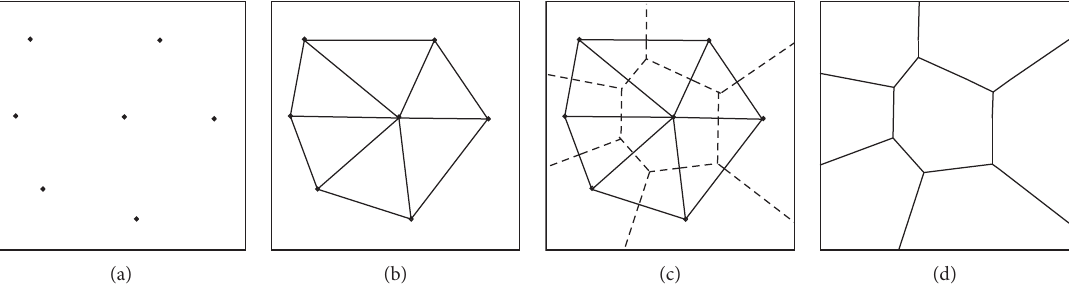
Figure 1: Four steps to generate random Voronoi polygons